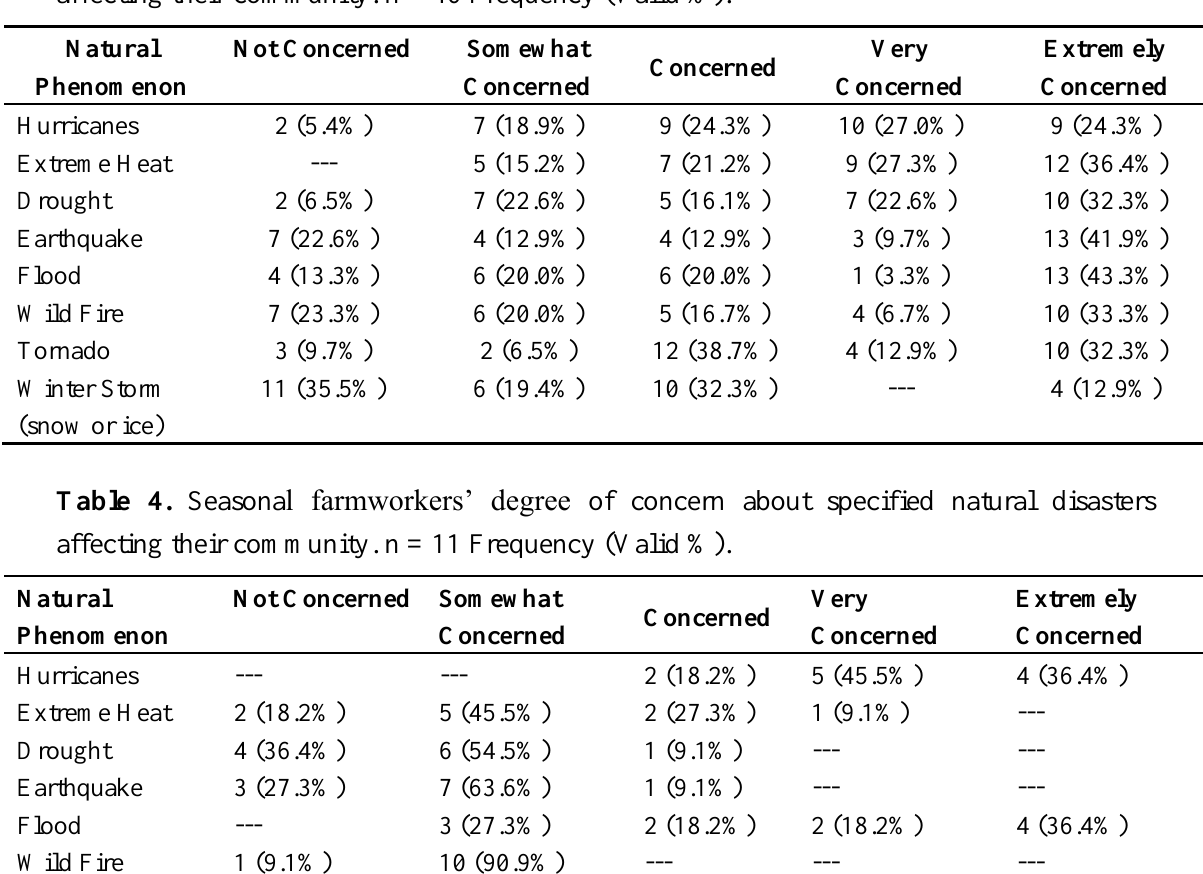
Table 3. Migrant farmworkers’ degree of concern about specified natural disasters affecting their community. n = 46 Frequency (Valid %).